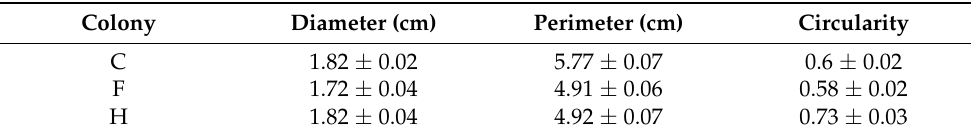
Table 1. Effect of fagopyrin and hypericin on colony features. Quantitative results expressed as means ± standard error of the mean (n = 6) from representative colonies grown for 15 days in YPD plates under different treatments: control (C, no photosensitizer), 100 µM fagopyrin (F) and 100 µM hypericin (H).